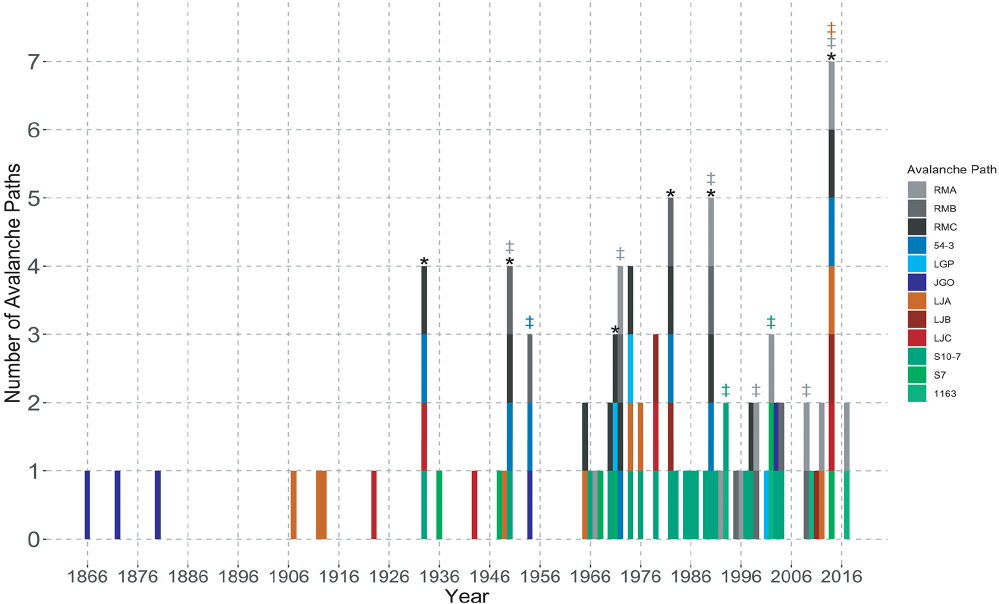
Figure 5. Number of individual avalanche paths in which an avalanche event occurred in any given year. Avalanche years with ‡ (gray is WF, dark blue is GTSR, orange is Swan, green is JFS) indicate years identified in at least two avalanche paths in the subregion. The ∗ represents avalanche years in common in at least one path from at least three of the four